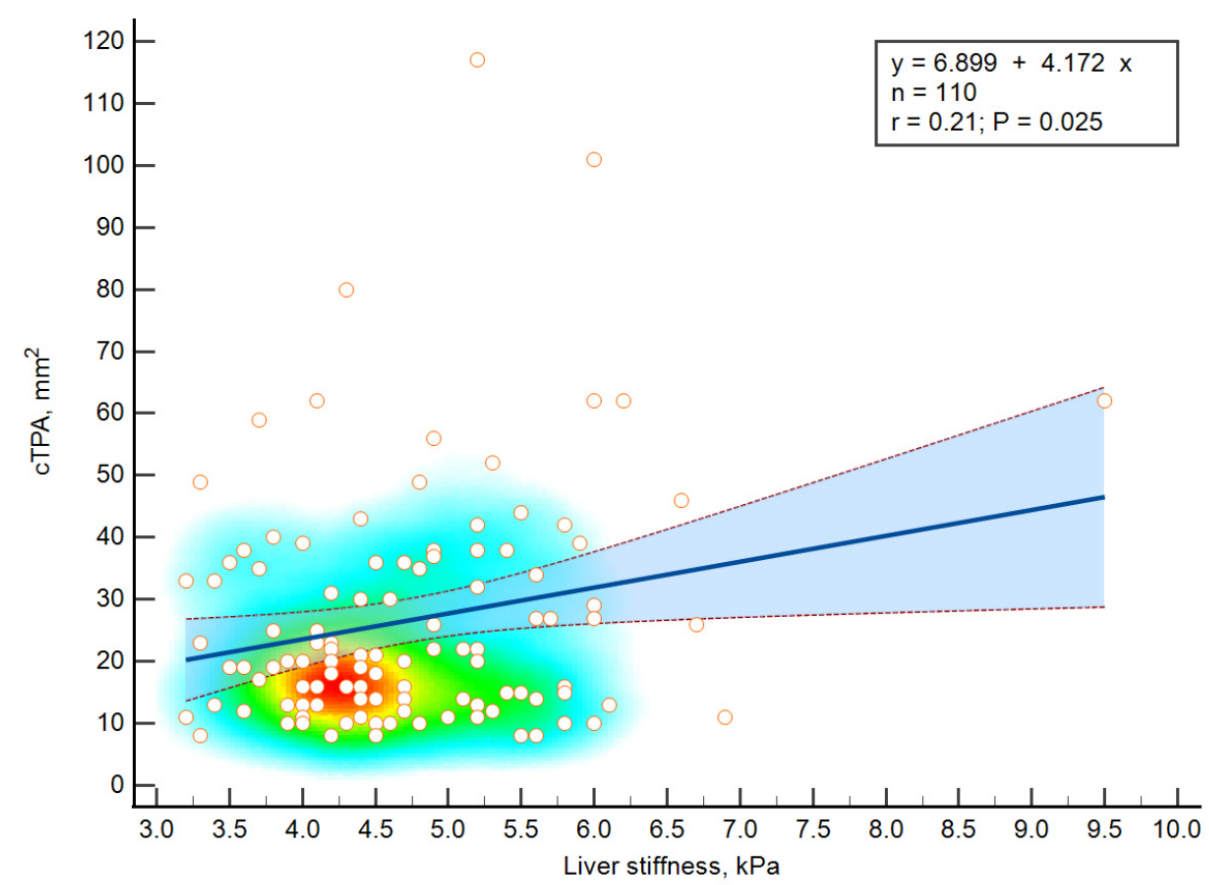
Figure 2. Results of linear regression analysis. The blue line represents the regression line, the dashed lines represent the 95% confidence interval. The heatmap reflects the density of